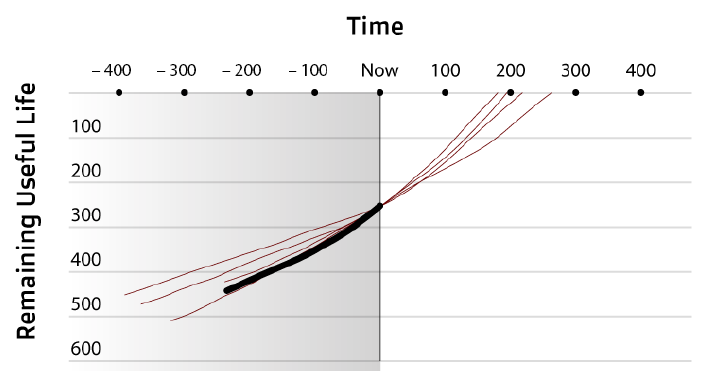
Figure 13. RUL trajectory comparison showing some past trajectories aligned with a current trajectory. The current trajectory is represented with the black line and the past trajectories are represented with the thin red lines.The past trajectories are aligned by the time they had a prognostic similar to the last prognostic of the current trajectory. With this representation we can see how the other trajectories behaved after this point. When there is a new prognostic, the trajectories are re-aligned using the new prognostic